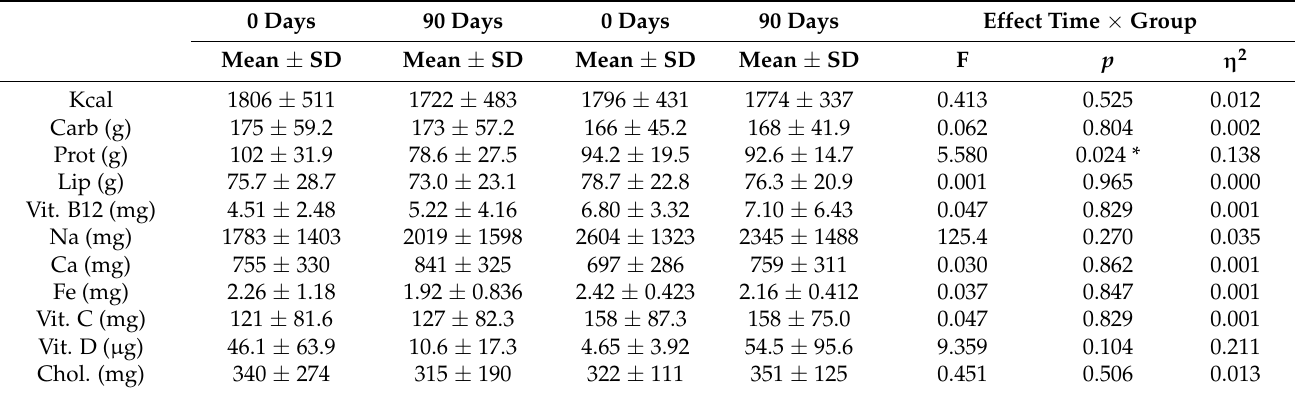
Table 2. Diet assessment of MTB and